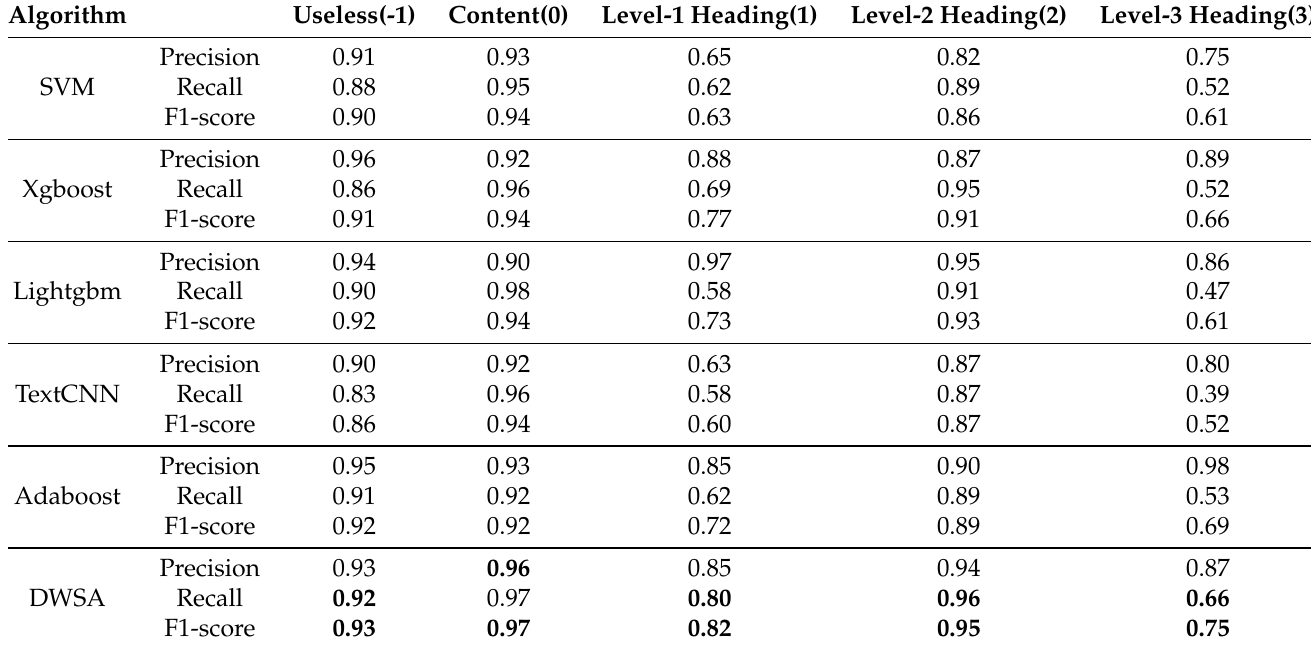
Table 3. Experimental results of insurance data set include precision, recall, and f1-score. The SVM algorithm, the Xgboost algorithm, the Lightgbm algorithm, the TextCNN algorithm, and the Adaboost algorithm are selected for comparison. The bold numbers are the best